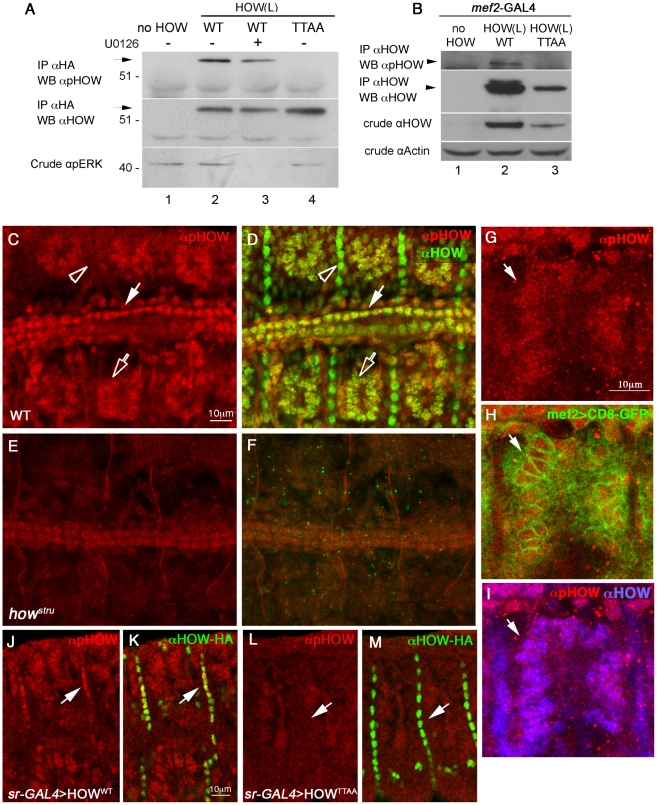
Phosphorylated HOW is detected in the nuclei of somatic muscles and cardioblasts.A. Anti-pHOW (pT64) antibody reacts with HOW, in a phosphorylation-dependent manner. HOW protein was immunoprecipitated with an anti-HOW antibody from S2R+ cells transfected with either HOW(L)WT, treated (or not) with U0126 (lanes 3, 2 respectively), with HOW(L)TTAA (lane 4), or no HOW (lane 1). The IP was reacted with anti-pHOW (pT64) antibody (top) or with anti-HOW antibody (middle). The crude extract was reacted with anti-pERK antibody (bottom), confirming U0126 inhibition. Note specific reactivity of the anti-pHOW antibody. B. Anti-pHOW (pT64) antibody reacts with HOW protein overexpressed in embryonic muscles and heart. Transgenic UAS-HOW(L)WT (lane 2) and UAS-HOW(L)TTAA (lane 3) flies or wild-type controls (lane 1) were crossed to the mef2-GAL4 driver line. Embryos were collected, and protein extracts were subjected to IP with an anti-HA antibody followed by Western with anti-pHOW (pT64) antibody (top), and anti-HOW antibody (2nd from top). Crude extracts were reacted with anti-HOW (2nd from bottom), and anti-Actin (bottom) as a loading control. C-F. Drosophila embryos stained with anti-pHOW (pT64) exhibit specific staining in somatic muscles and heart cardioblasts. Stage 16 WT (C,D) and how stru mutant (E,F) embryos were stained with anti-pHOW (pT64) (red, C–F) and anti-HOW (green in merge D,F). Embryos are oriented dorsal to the top and anterior to the left. (C,D) Note the staining in muscles (hollow arrow), heart cardioblasts (white arrow) and the lack of pHOW staining in the muscle attachment sites (arrowhead). (E,F) Weak staining in cardioblasts in how stru−/− mutants. G–I. Drosophila embryos expressing CD8-GFP, which localizes at the plasma membrane, but also often concentrates in the ER surrounding the nuclei, in muscles under mef2-GAL4, were stained with anti-pHOW (red, G) shown merged with GFP (green, H) and with HOW (blue, I). J–M. HOW(L) overexpressed in embryonic tendon cells reacts with the anti-pHOW (pT64) antibody. Embryos expressing UAS-HOW(L)WT-HA (J,K) or UAS-HOW(L)TTAA–HA (L,M) in the tendon cells under sr–GAL4 were stained with anti-pHOW (pT64) (red, J–M) and anti-HA (green, K, M, merged with the anti-pHOW staining). Arrows mark tendon cells reactive with anti-pHOW upon expression of HOW(L)WT (J,K), or non-reactive upon expression of the phospho-mutant (L,M).